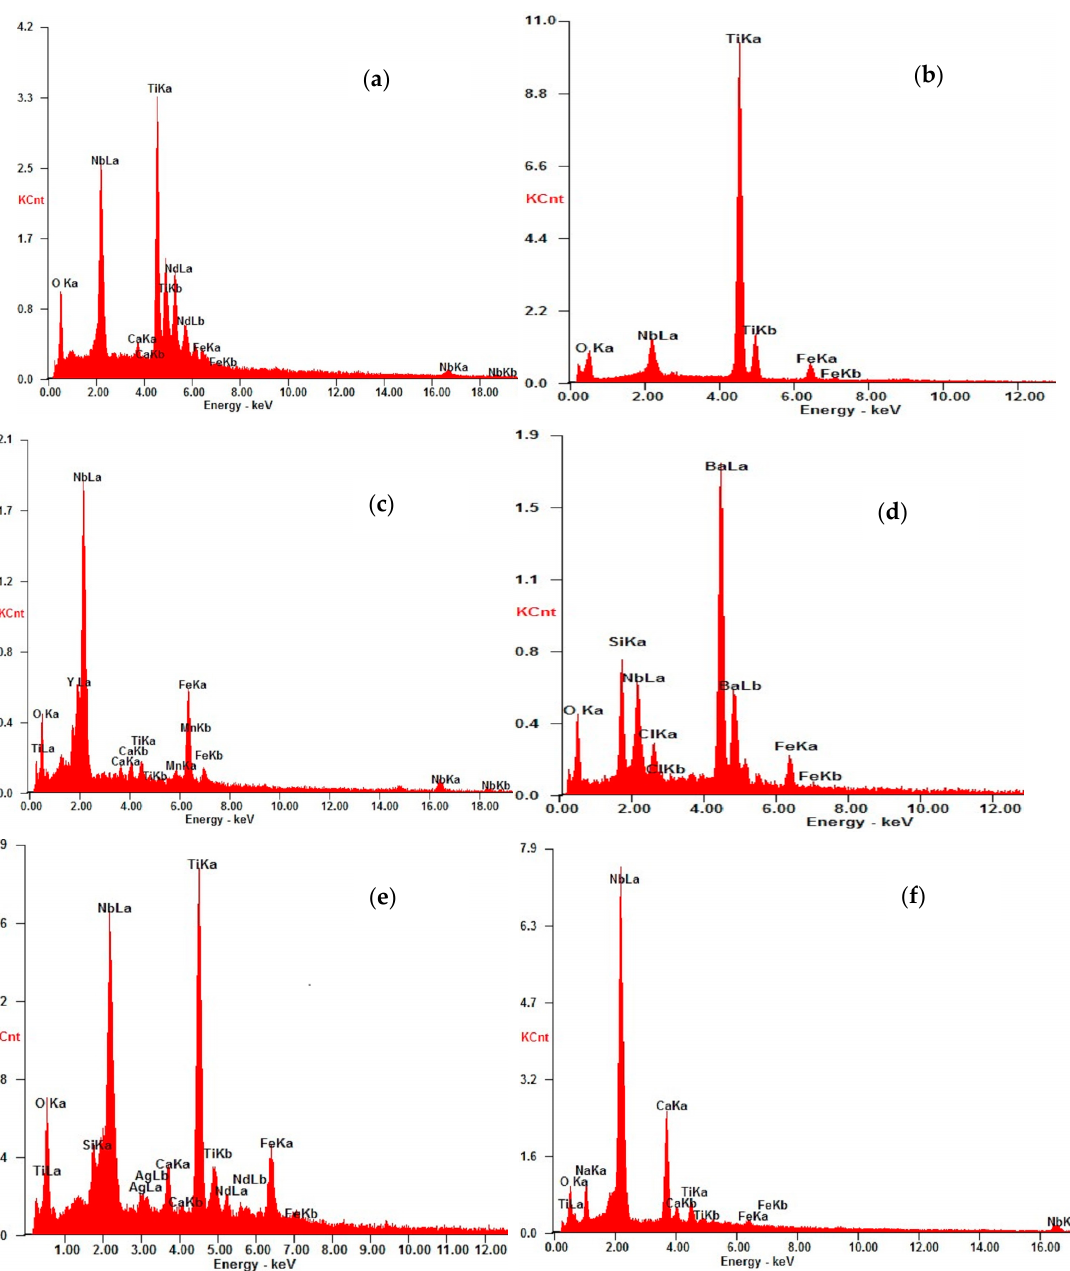
Figure 4. The types of minerals in the samples and the occurrence characteristics of niobium miner- als. ( a ): Nioboaeschynite-(Nd) is associated with other silicate minerals and other metal oxides. ( b ): Ilmenorutile and nioboaeschynite-(Nd) are associated with riebeckite, and baotite is associated with quartz and rare-earth minerals. ( c ): Ilmenorutile is associated with other silicates and carbonate, and nioboaeschynite-(Nd) is encased in carbonates. ( d ): Ilmenorutile is associated with fluorite and other metal oxides.